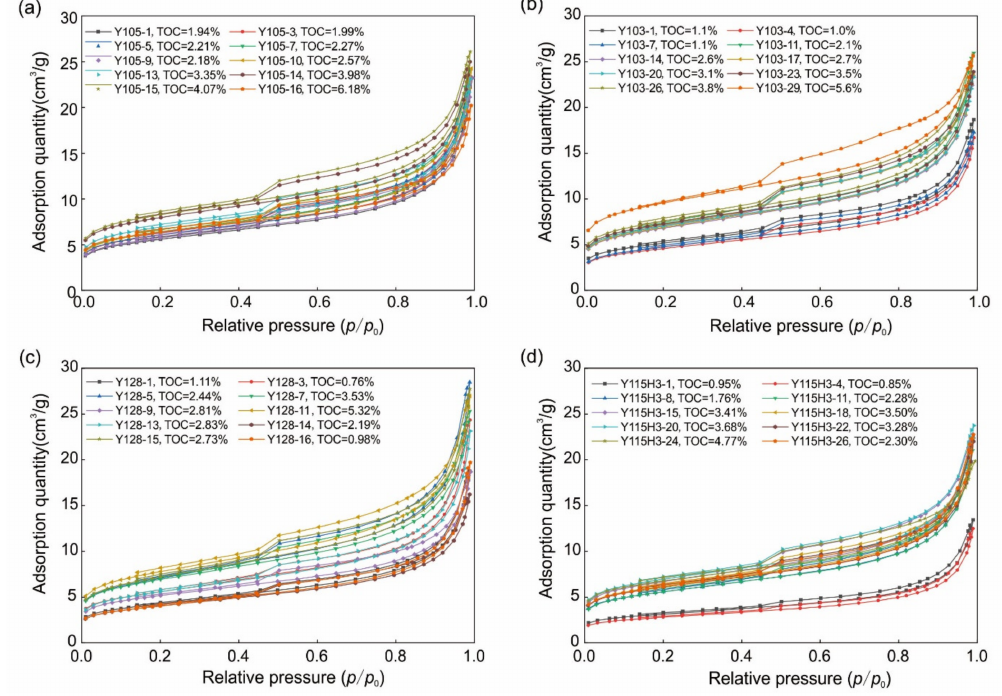
Figure 4. Low-temperature N 2 adsorption (LTNA) experimental results of the samples from four representative wells, including adsorption and desorption curves (( a ): Well Y105, ( b ): Well Y103, ( c ): Well Y128, ( d ): Well Y115H3).